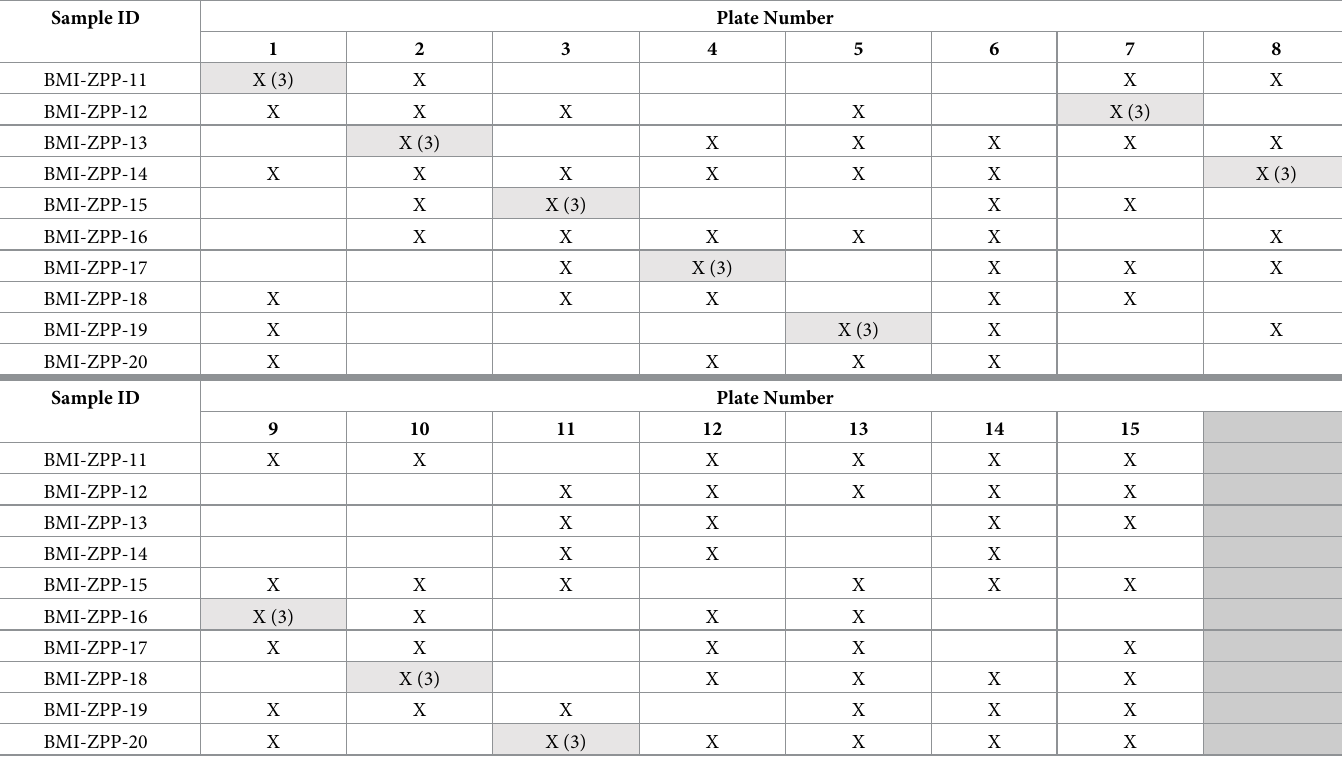
An “X” indicates that sample was analyzed on the indicated plate. An “X (3)” (shaded) indicates that sample was analyzed on the indicated plate three